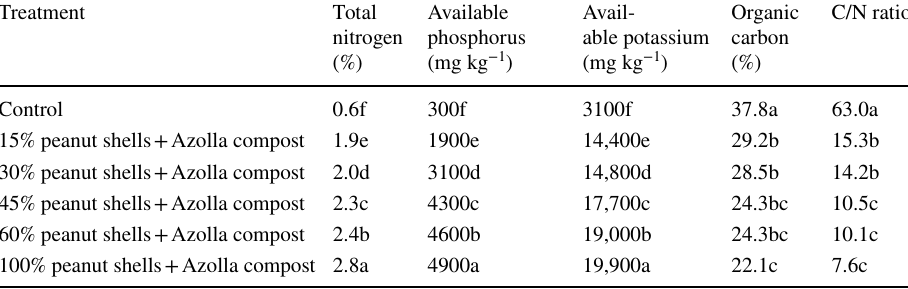
Table 3 Some chemical properties of growth media